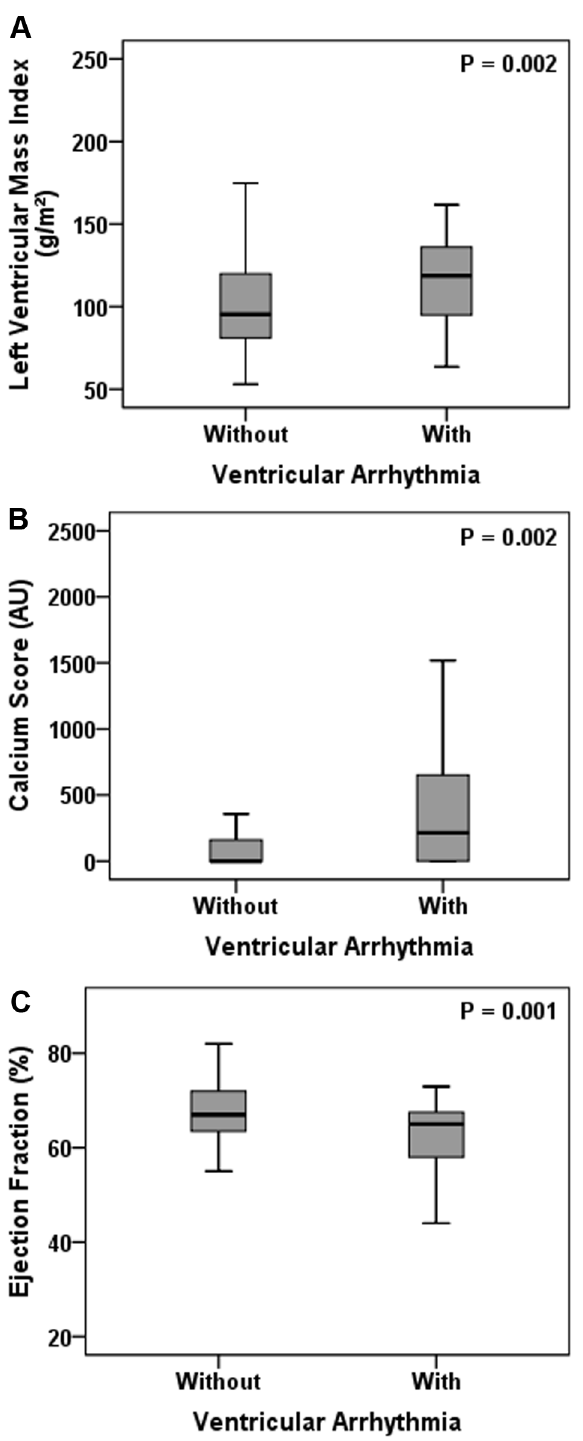
Figure 1. Cardiovascular parameters according to the presence of ventricular arrhythmia. Left Ventricular Mass Index (A), Calcium Score (B) and Ejection fraction (C) in patients with and without ventricular arrhythmia.